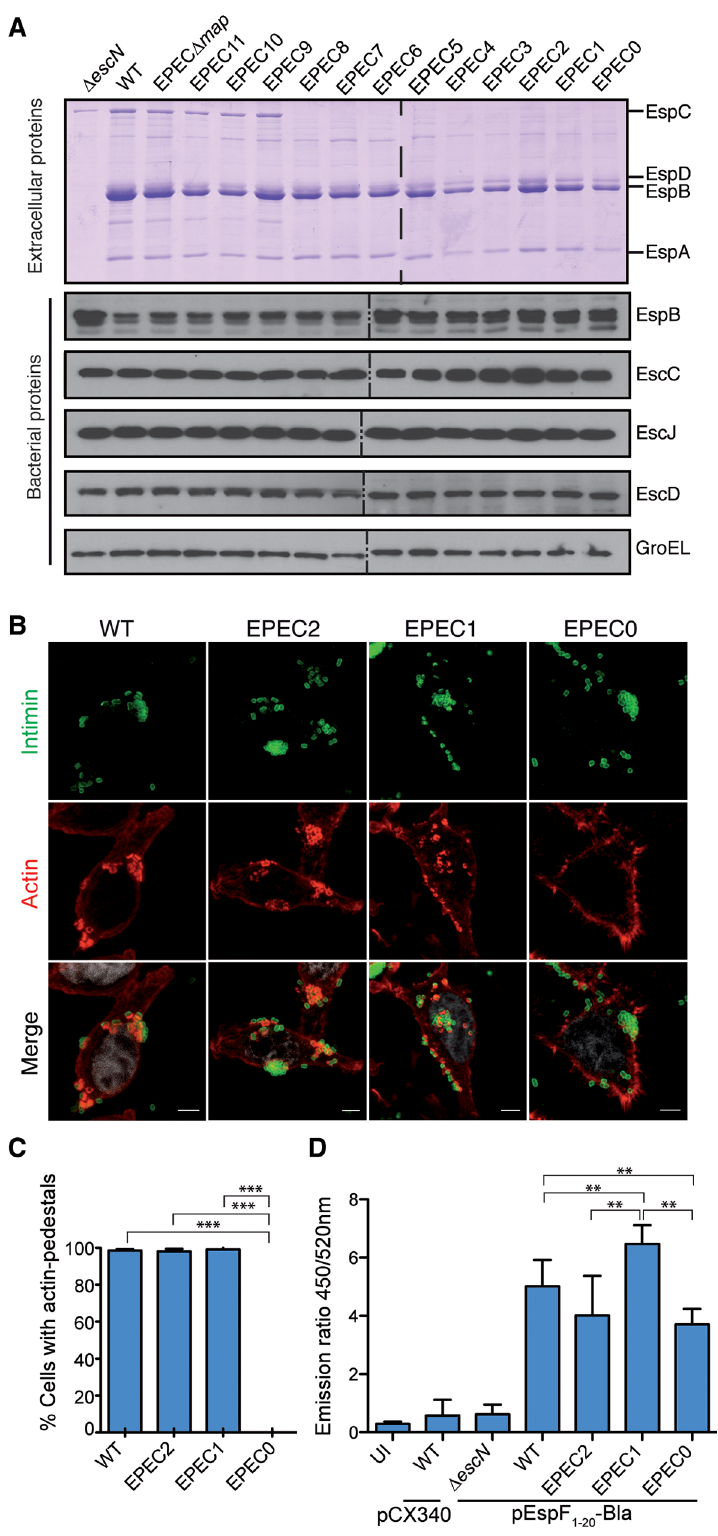
Fig 2. Functionality of T3SS of the EPEC effector mutants. A . Analysis of secreted and bacterialproteins in the indicatedEPEC strains after 4 h of growth in DMEM at 37˚C. Top panel:Coomassie staining of